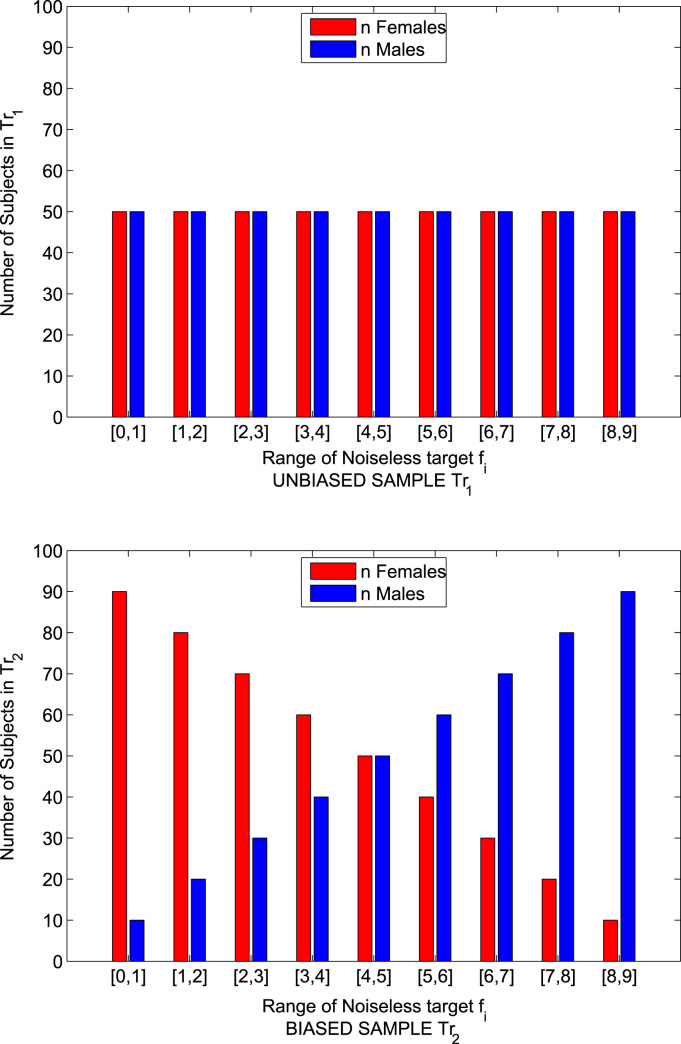
No of subjects by gender over unit intervals of fi in the unbiased training sample Tr1 are shown in (a). The corresponding barchart for the biased training sample Tr2 is shown in (b).